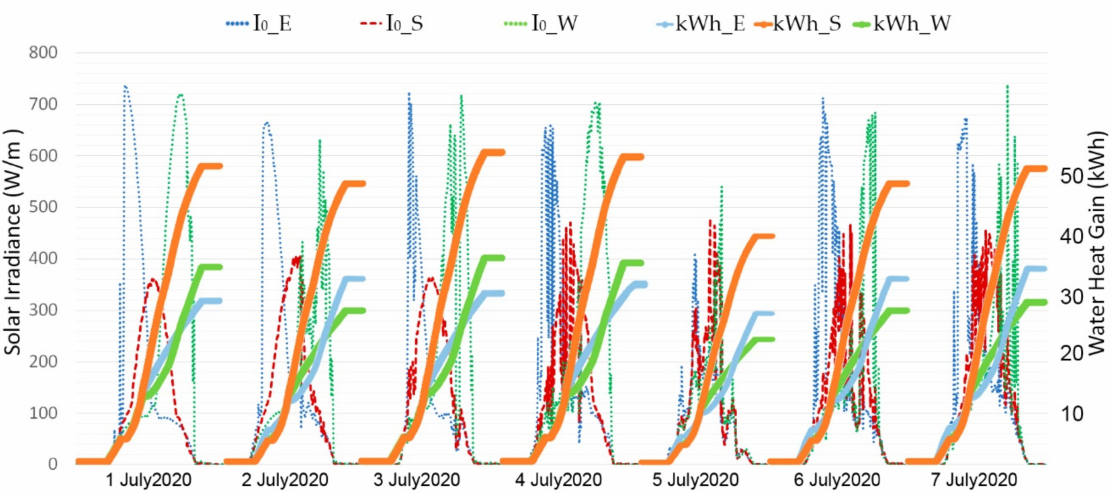
Figure 6. Solar irradiances on the façade and water heat gain in July. Figure 5 demonstrates the measured solar irradiance and the water heat gains during the selected winter period in three different orientations. Panels oriented in a southern direction had a daily energy absorption rate of 39 kWh on sunny winter days when the peak solar irradiance on the southern façade was 800 W/m 2 . On cloudy winter days,